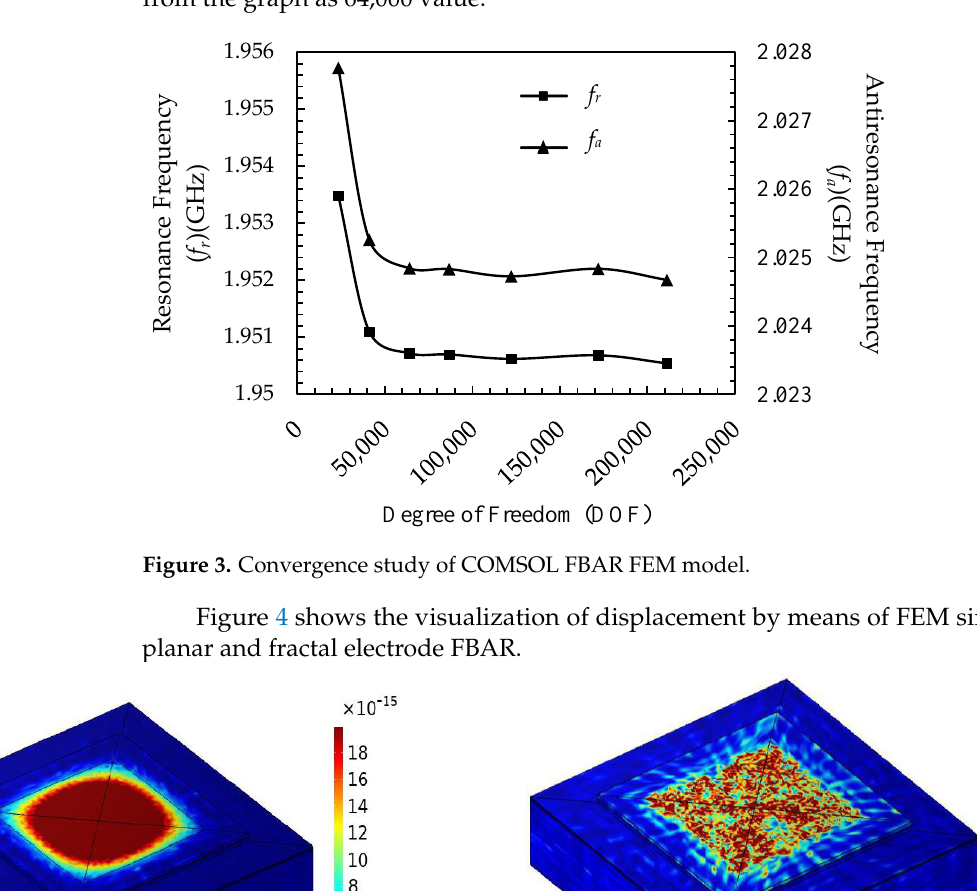
Table 2. The parameters of the organic gas used for